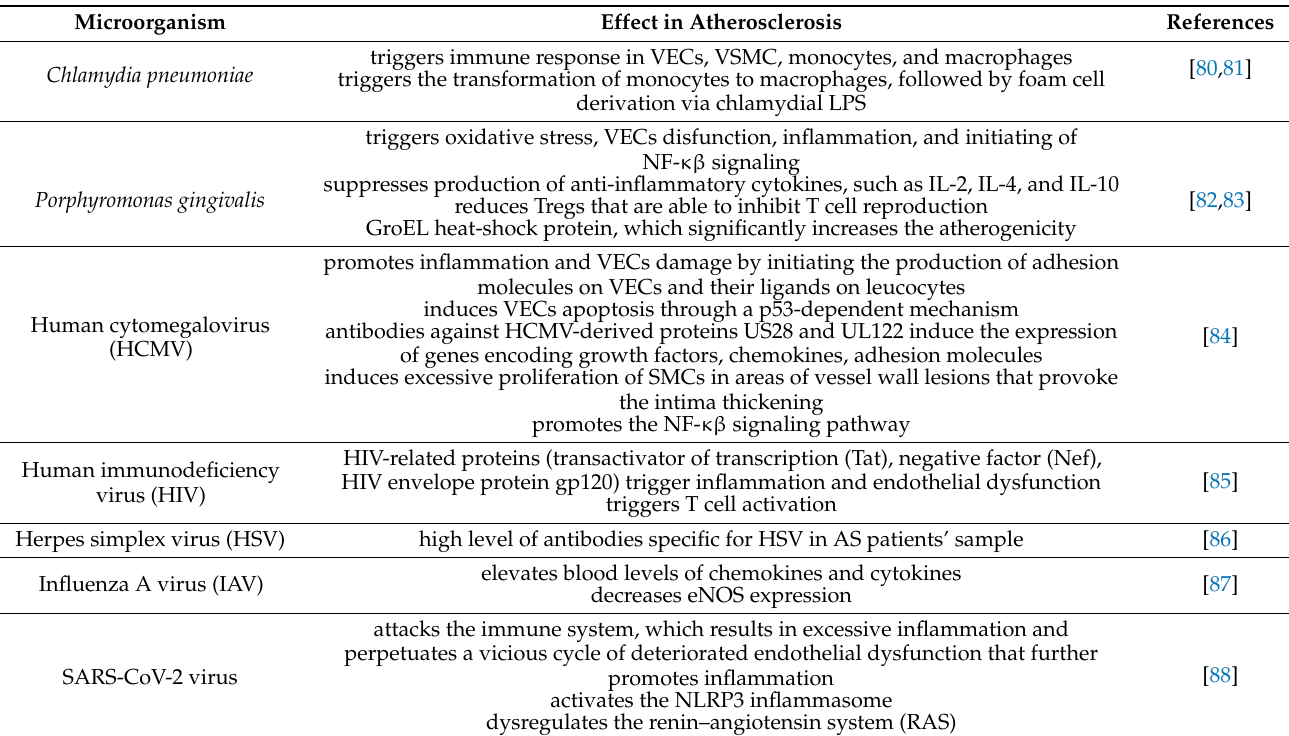
Table 2. Contribution of the selected pathogens to atherosclerosis